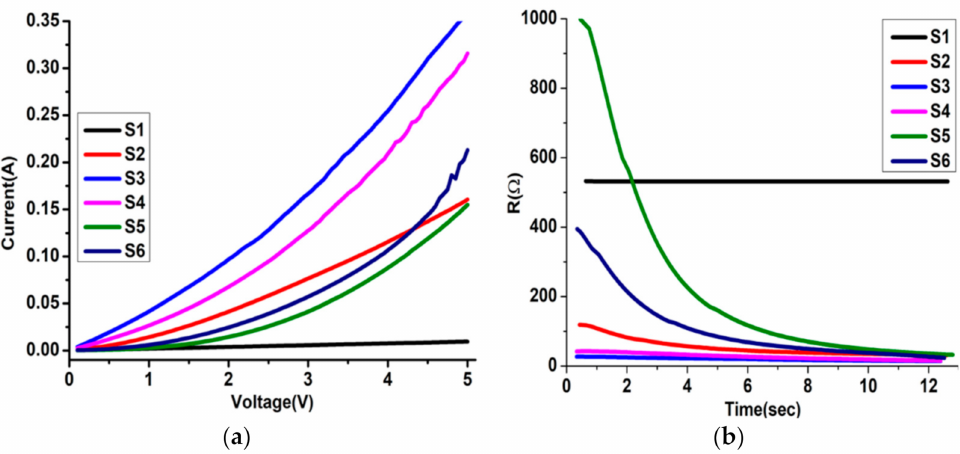
Figure 7. ( a ) The characteristic I–V curves of S1–S6 thin films and ( b ) the corresponding change in R-t curves of the measured I–V curves of each